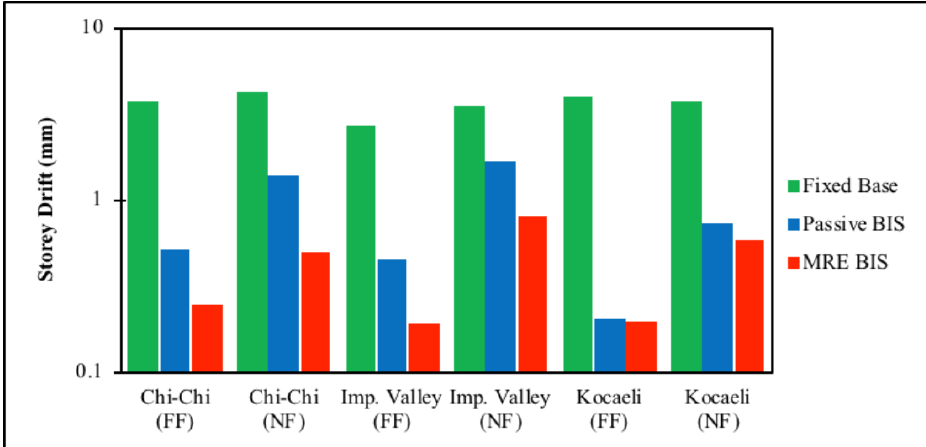
Figure 12. Peak storey drifts response at storey